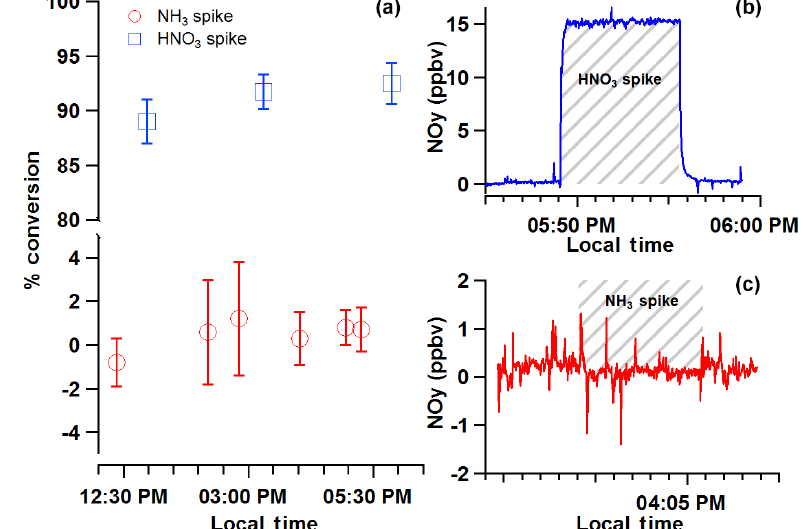
Figure 10. Measurement of HNO 3 and NH 3 conversion in ambient air at an inlet set temperature of 650 ◦ C. (a) Measured conversion efficiencies for standard additions of HNO 3 and NH 3 to the NOAA TD-CRDS inlet sampling ambient air in Boulder, CO, on 9 August 2016. (b, c) Time series of measured NO y during standard additions. The data are the difference between two NO y measurement channels, one with and one without the standard addition, to cancel the variation in ambient NO y during the